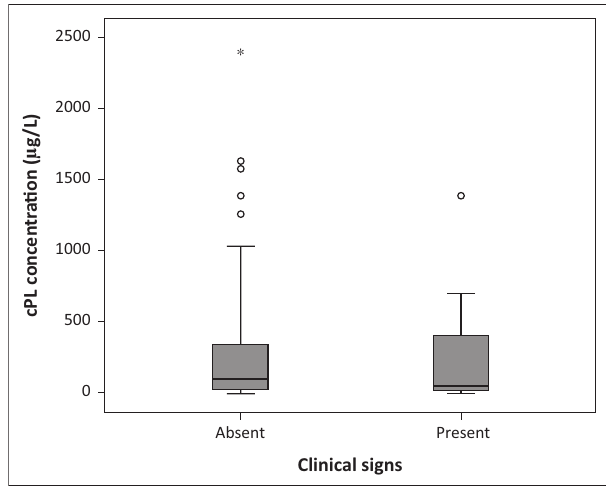
) between canine s